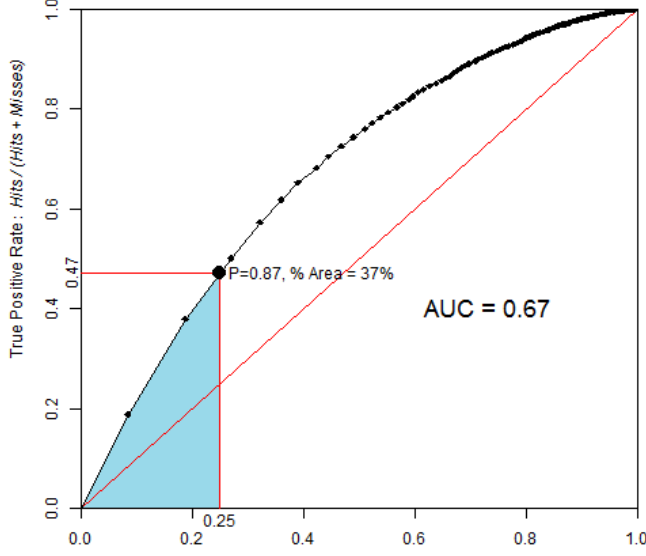
Figure 6. ROC curve obtained by comparing the probability of post-1994 deforestation map versus observed deforestation between 1994 and 1999, using 100 bins and the equal probability increment method. The point identified in the ROC curve corresponds to the area expected to be deforested during 1994–1999, assuming pre-1994 trends were to continue beyond 1994. The blue area corresponds to the partial AUC focused on high probability values, which are 0–0.25 on the False Positive Rate